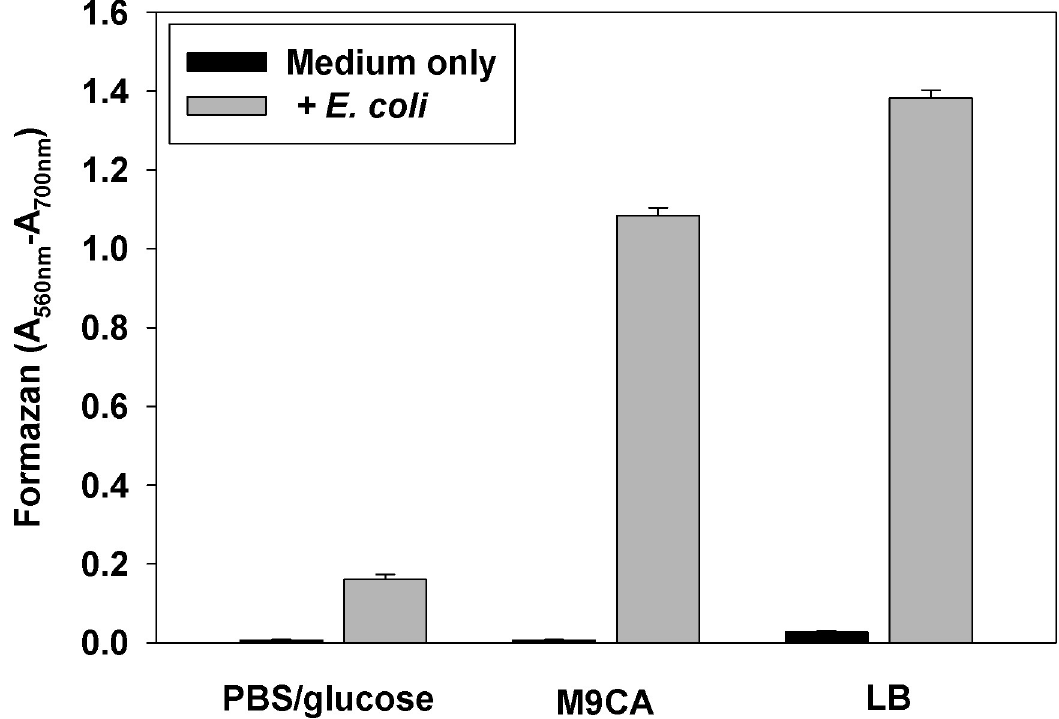
Fig 1. Effect of incubation medium on MTT reduction by E . coli . E . coli GC4468 strain was grown to mid-log phase in LB medium, the cells were thoroughly washed and resuspended to OD 600 = 0.1 in PBS + glucose, M9CA medium, or LB medium. The MTT assay was performed as described in Materials and Methods section and formazan crystals were solubilized with SDS-HCl. Results are expressed as difference between absorbance at 560 nm (formazan peak) and 700 nm (background). Experiments were repeated twice, each sample in triplicates. Mean ± S.D. is